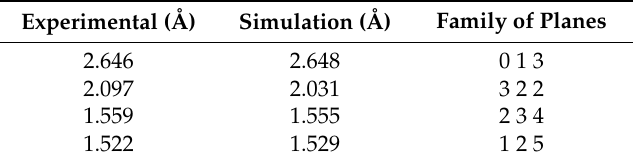
Table 2. Comparison of experimental diffraction pattern data and simulation with magnetite.